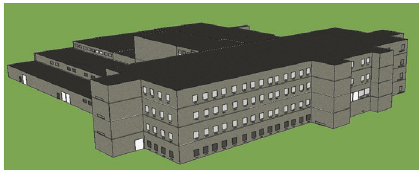
Figure 1: 3D model of the S. J. Carew building using IDA Indoor Climate and Energy program.